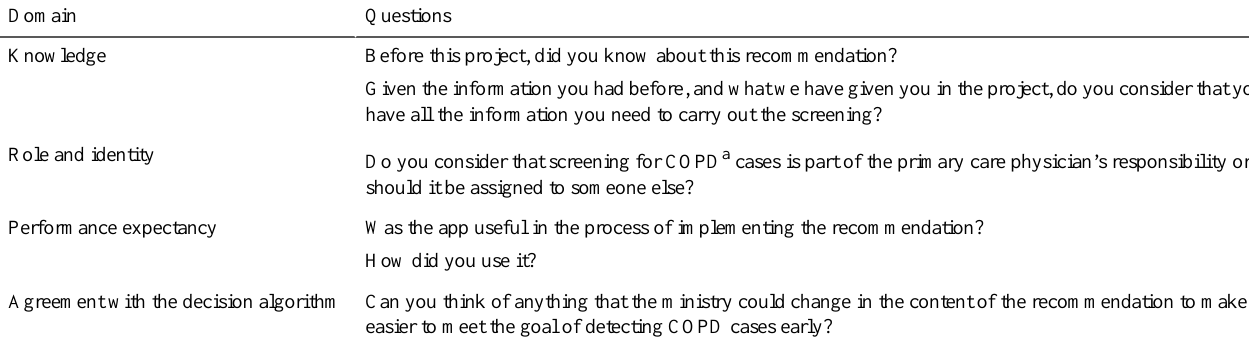
Table 3. Example 1